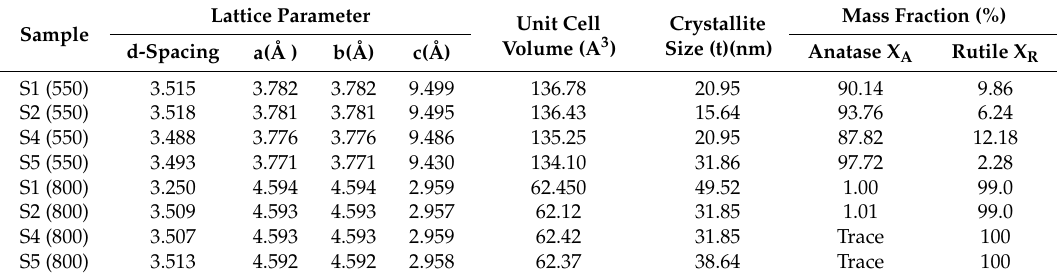
Figure 7. X-ray diffraction patterns of the samples calcined at different temperatures; ( a ) S1 (500), S2 (500), S4 (500) and S5 (500) and ( b ) S1 (800), S2 (800), S4 (800) and S5 (800). Table 2. Lattice parameters, unit cell volume, average crystallite size and anatase/rutile mass fraction obtained from XRD patterns of the samples in column 1.